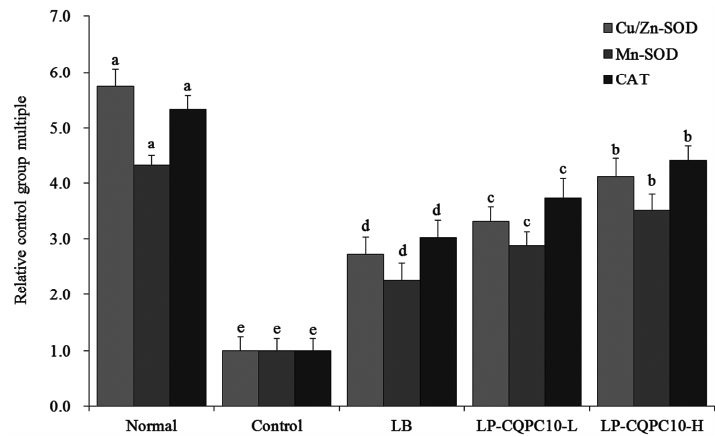
Figure 4. mRNA expression levels of Cu/Zn ‐ SOD, Mn ‐ SOD and CAT in the small ‐ intestine tissue of mice. Values presented are the mean ± standard deviation. a–e Mean values with different letters in the same bars are significantly different ( p < 0.05) according to Duncan’s multiple ‐ range test. LB: Lactobacillus bulgaricus (1.0 × 10 9 colony ‐ forming unit (CFU)/kg body weight (bw)); LP ‐ CQPC10 ‐ L: Lactobacillus plantarum CQPC10 (1.0 × 10 8 colony ‐ forming unit (CFU)/kg body weight (bw)); LP ‐ CQPC10 ‐ H: Lactobacillus plantarum CQPC10 (1.0 × 10 9 colony ‐ forming unit (CFU)/kg body weight (bw)).